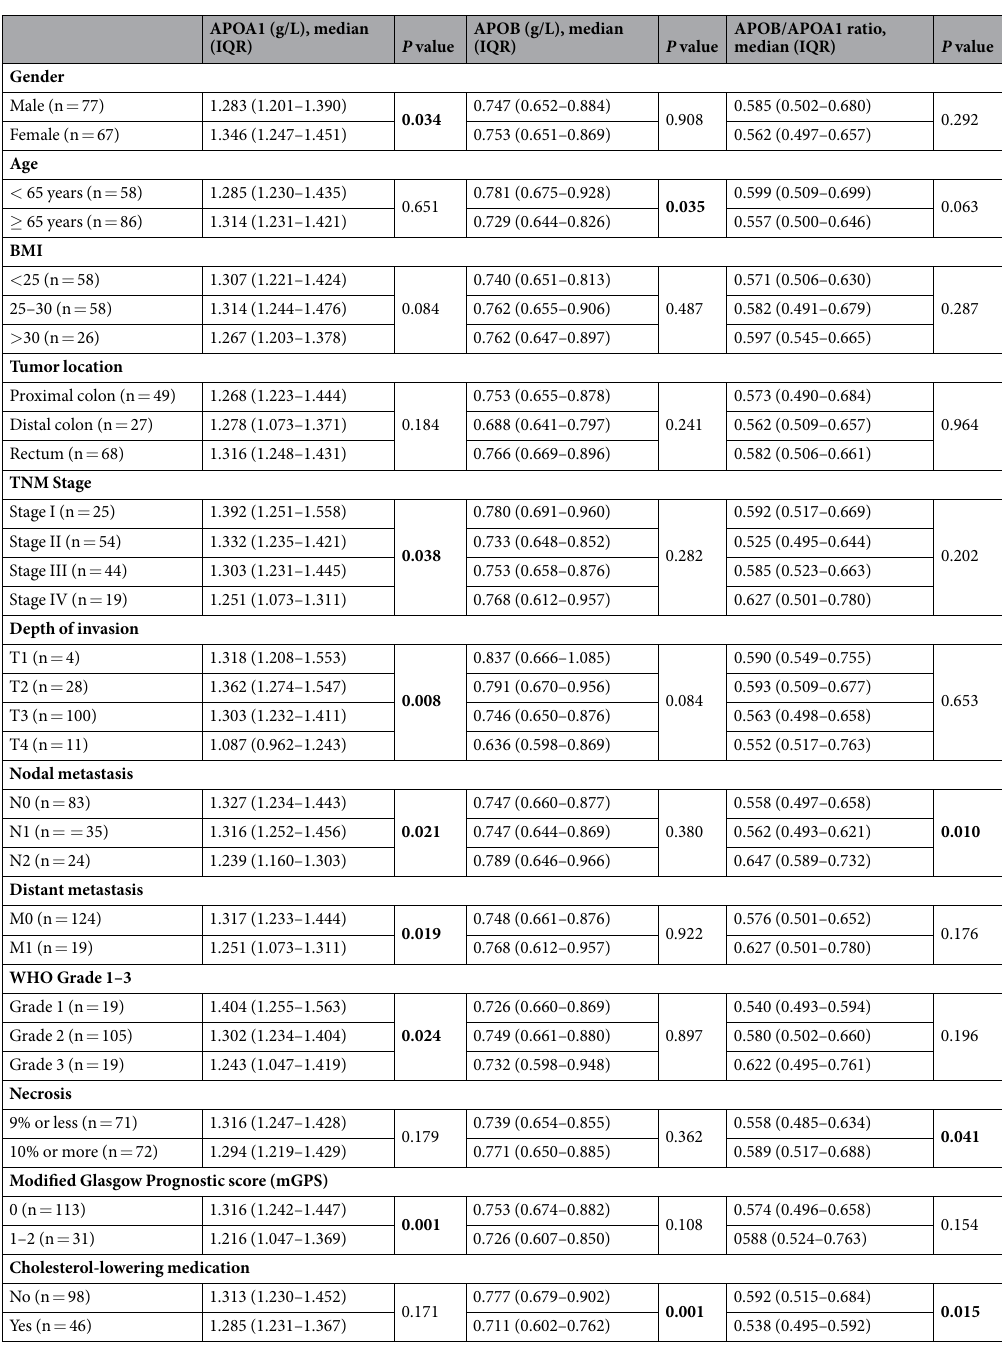
Table 2. Serum apolipoprotein A1 (APOA1) and apolipoprotein B (APOB) levels in relation to clinical and pathological characteristics of tumors Abbreviations: IQR: interquartile range; BMI: body mass index. P values are for Mann-Whitney or Kruskal-Wallis